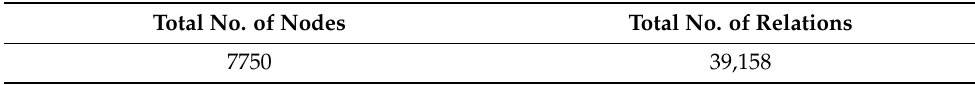
Table 3. No. of nodes and relation in the restaurant domain